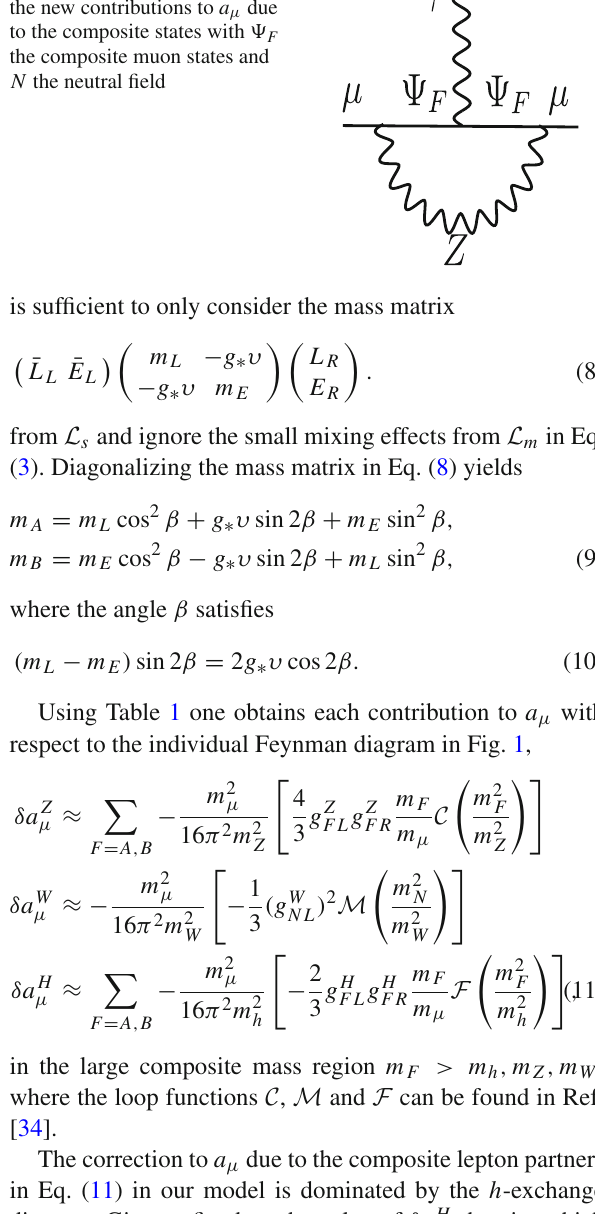
Fig. 1 Feynman diagrams